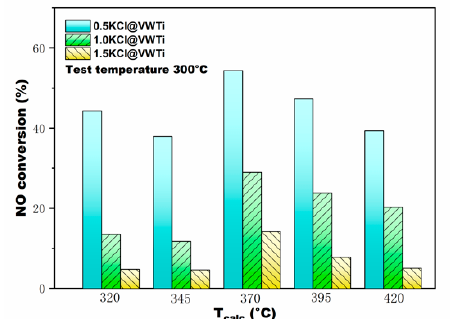
Figure 2. NO conversion of three n(K)/n(V) of KCl poisoned V 2 O 5 -WO 3 /TiO 2 catalysts at different T calc . The test temperature was 300 °C.